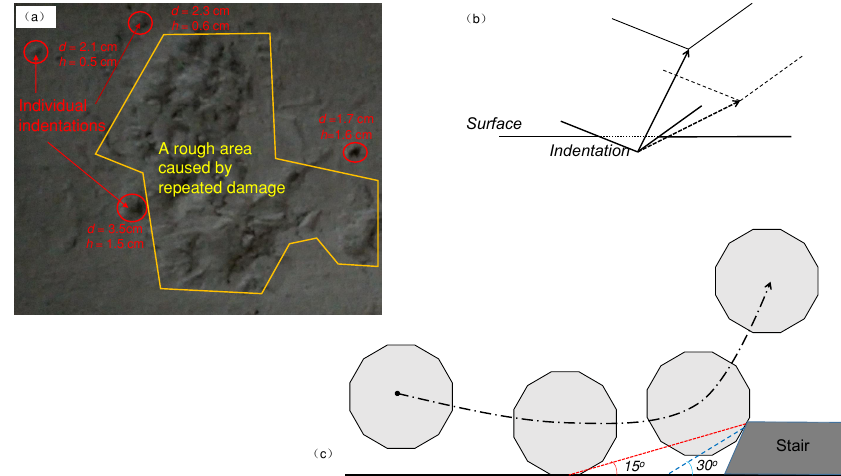
Figure 12. (a) Individual indentations and a rough area caused by the impacts and their influence on the rebound motion; (b) a simplified configuration used to evaluate the effect of the indentation; and (c) a small stair model used to evaluate the effect of the